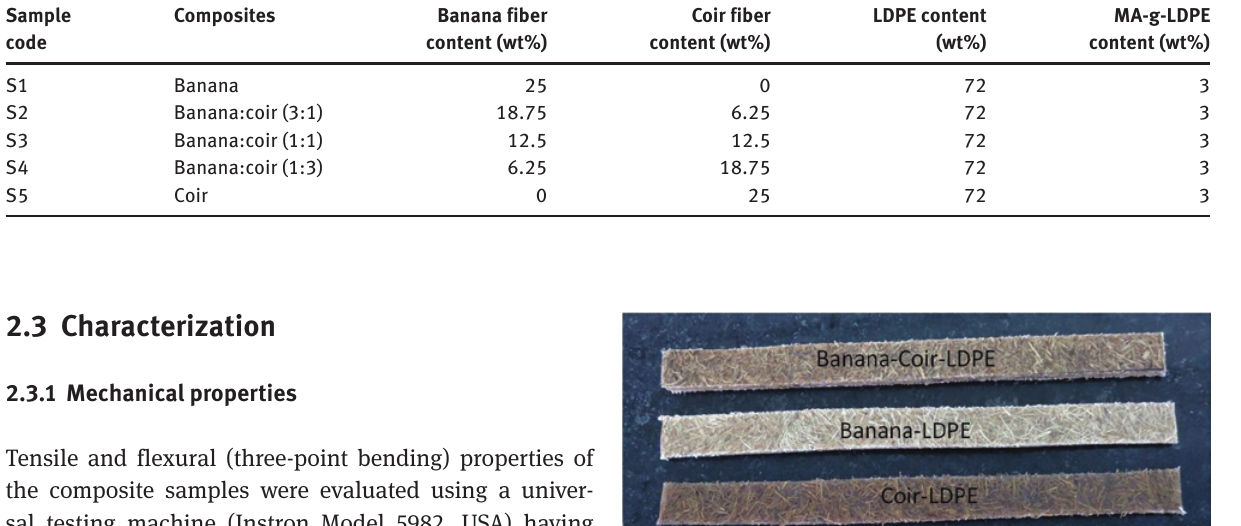
Table 2: Composition of the studied formulations. Sample